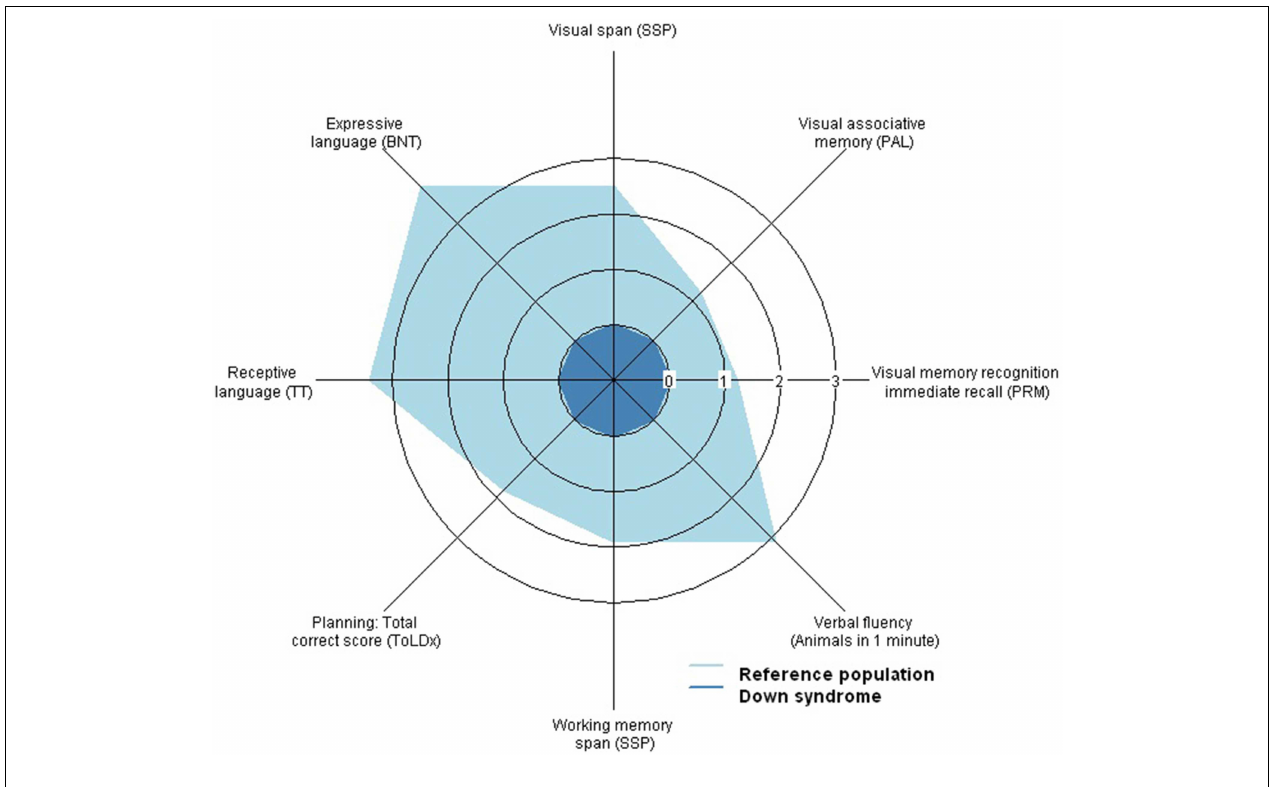
For this purpose, the performance of the participants with DS has been standarized to 1 which is equivalent to an effect size of d = 0 . DS adults show a severe dyfunction of language capacity (| d | > 3), a substantial deficit on attention span and executive functions (| d | > 1.5) and a moderate deficit in episodic memory(| d | >